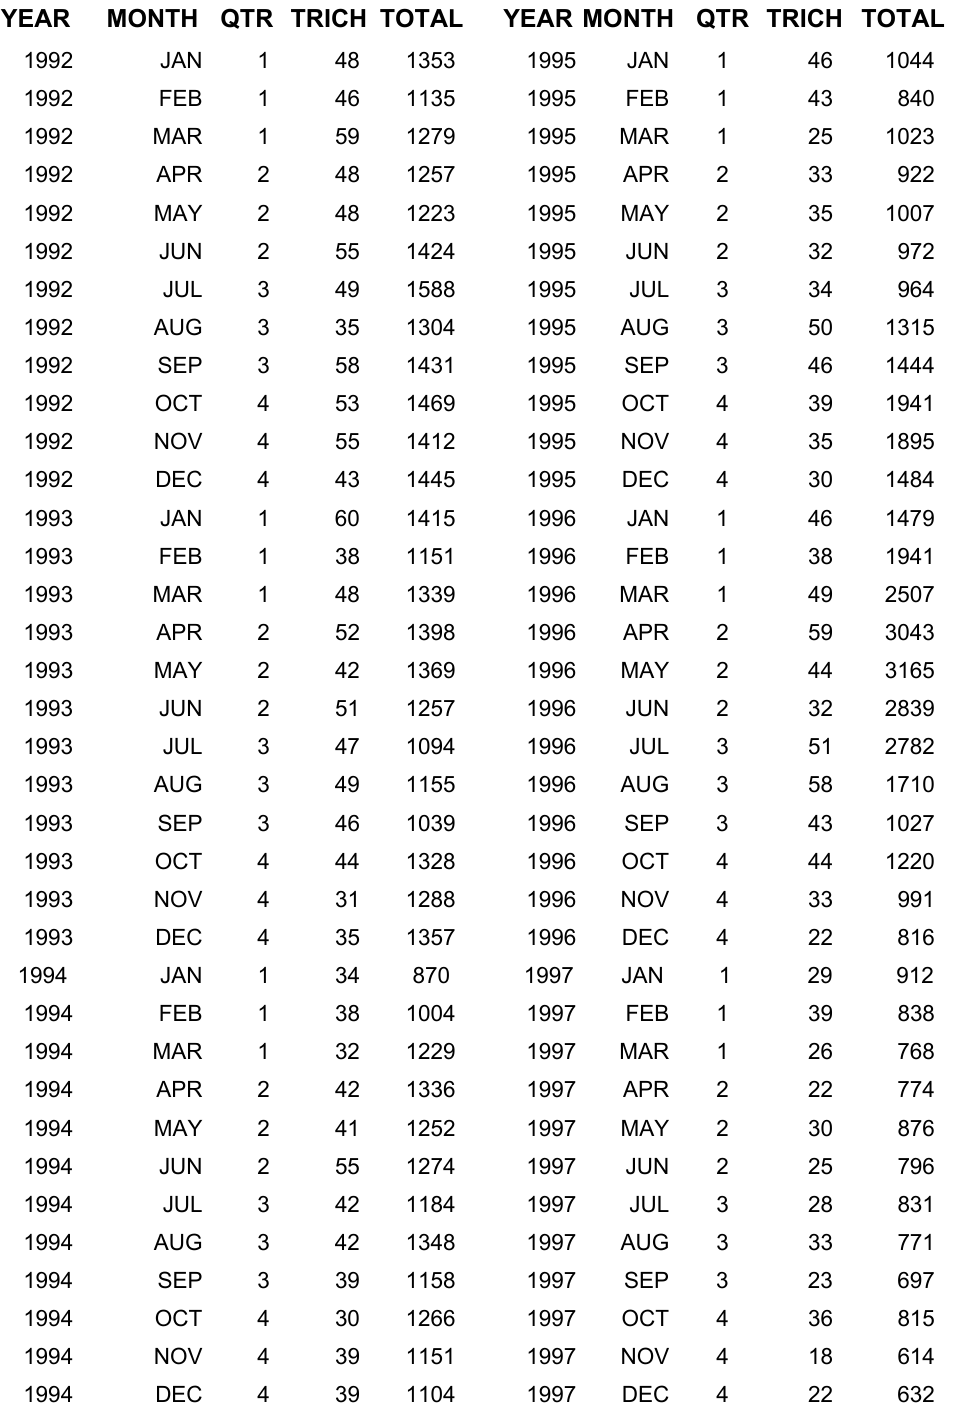
Total Number of Papanicolaou Smears with T. vaginalis vs. Total Number of Smears by Year, Month, and Quarter